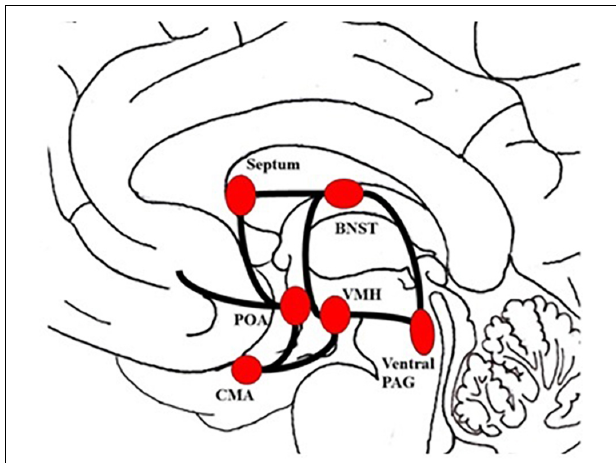
FIGURE 1 | Schematic visualization of the LUST system. The figure was drawn by JF, based on theoretical concepts by Solms and Turnbull (2002) and Panksepp (2011). BNST, bed nucleus of the stria terminalis; CMA, cortico-medial amygdala; POA, preoptic area; PAG, Periaqueductal gray; VMH, ventromedial